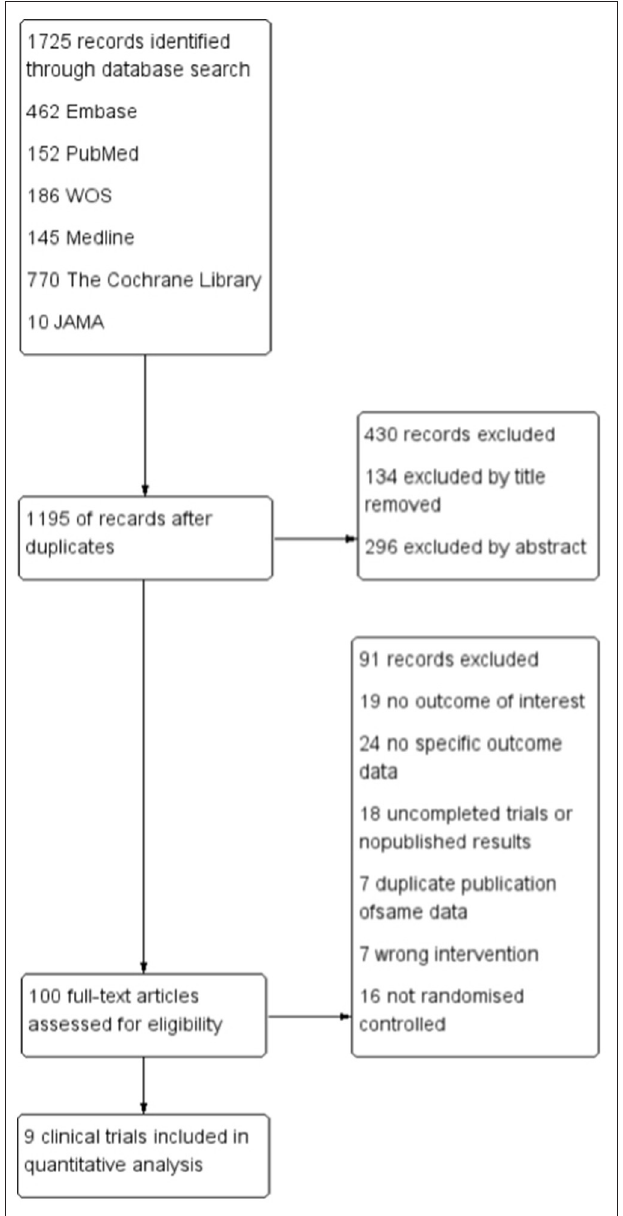
FIGURE 1 | Flow diagram of literature search and study